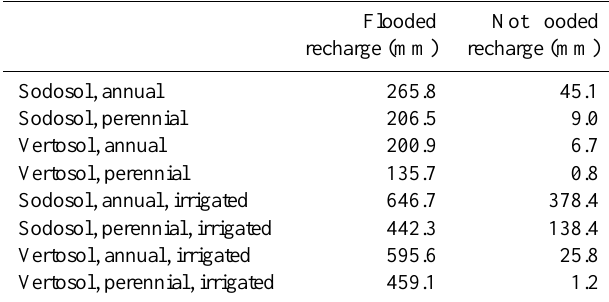
Table 2. Comparison between point-scale recharge in millimetres for the modelled period under the two most common soil types, vegetation types and irrigated vs. non-irrigated land, for flooded and non-flooded